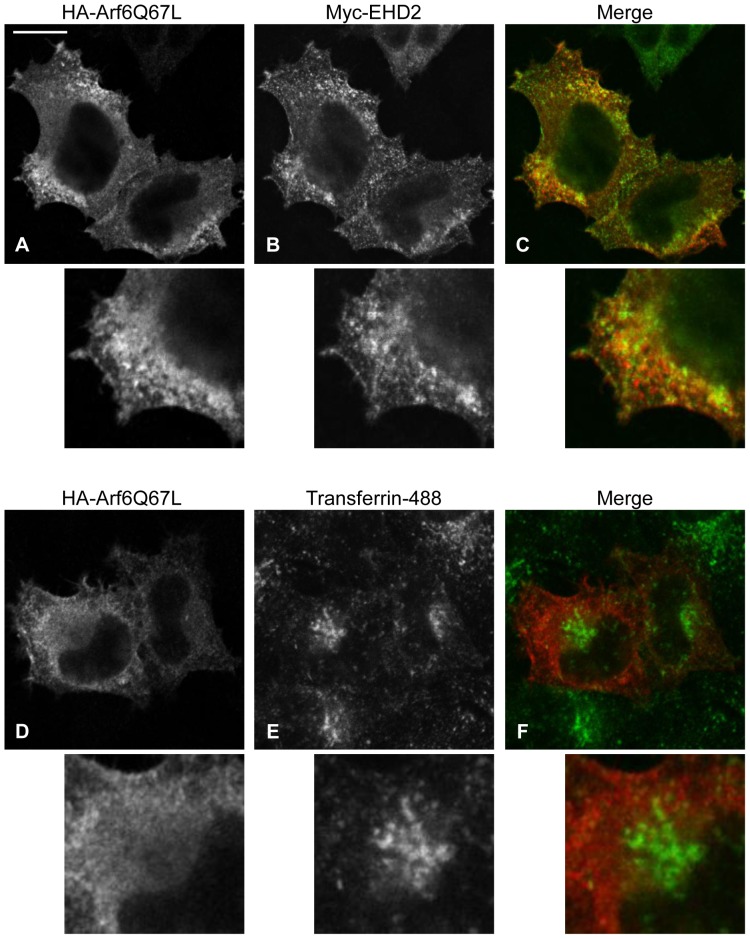
EHD2 localizes to PIP2-enriched Arf6Q67L-positive vacuoles.(A–C) HeLa cells growing on coverslips were transfected with HA-Arf6Q67L and Myc-EHD2 for 11 h. The cells were then fixed and stained with antibodies against HA and Myc. After addition of fluorochrome-conjugated secondary antibodies, the cells were analyzed by confocal microscopy. (D–E) HeLa cells growing on coverslips were transfected with HA-Arf6Q67L for 11 h. The cells were incubated in serum-free DMEM containing 0.5% bovine serum albumin during the last 3.5 h of transfection, and then pulsed with 1 µg/ml transferrin-488 for 20 min. The cells were then fixed and stained with antibody against HA. After incubation with fluorochrome-conjugated secondary antibody, the cells were analyzed by confocal microscopy. Insets are shown below each image. Bar, 10 µm. The confocal micrographs are representative of three independent experiments.